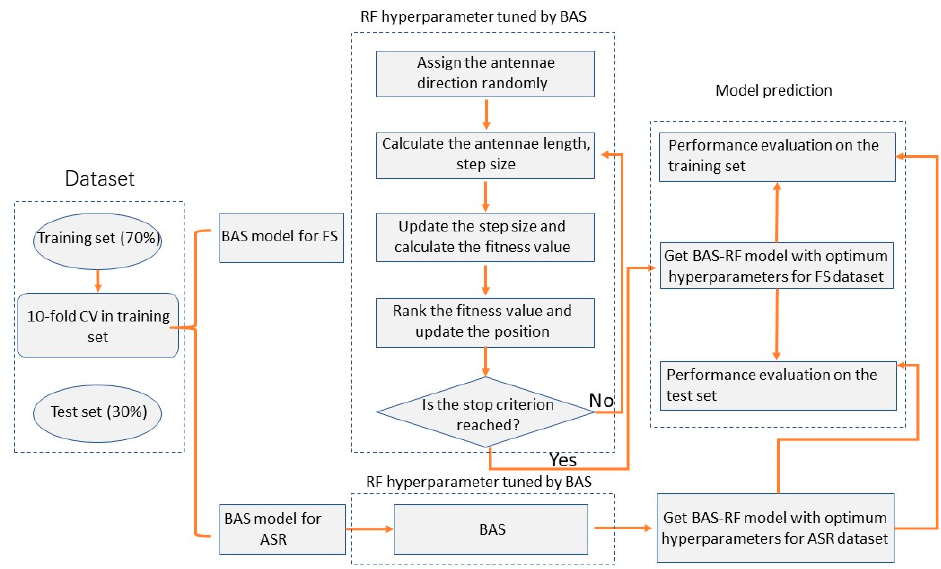
Figure 5. RF model training by 10-fold CV and BAS .